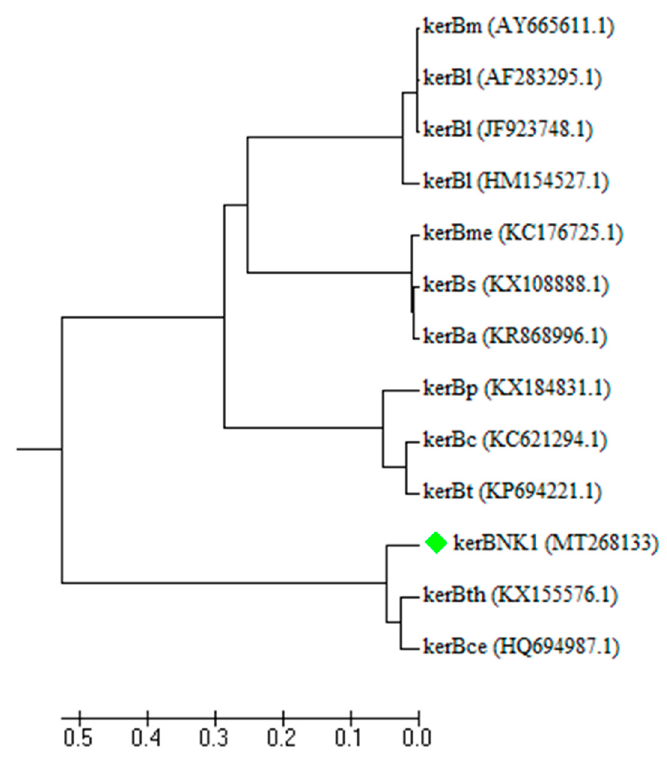
Figure 7. A phylogenetic tree of some selected keratinase genes of different Bacillus species was constructed in MEGA 7 and the evolutionary history was inferred using the unweighted pair group method with arithmetic mean (UPGMA). The tree is drawn to scale, with branch lengths in the same units as those of the evolutionary distances used to infer the phylogenetic tree. The keratinase genes ( ker ) considered in this study were from; Bm: Bacillus mojavensis ; Bl: Bacillus licheniformis ; Bme: Bacillus methylotrophicus ; Bs: Bacillus subtilis ; Ba: Bacillus amyloliquefaciens ; Bp: Bacillus Pumilus ; Bc: Bacillus circulans ; Bt: Bacillus tequilensis; Bth: Bacillus thuringiensis; Bce: Bacillus cereus . The keratinase gene ( kerBNK1 ) from Bacillus sp. Nnolim-K1 is indicated with a squared green tip. The GenBank accession numbers are shown in parenthesis.